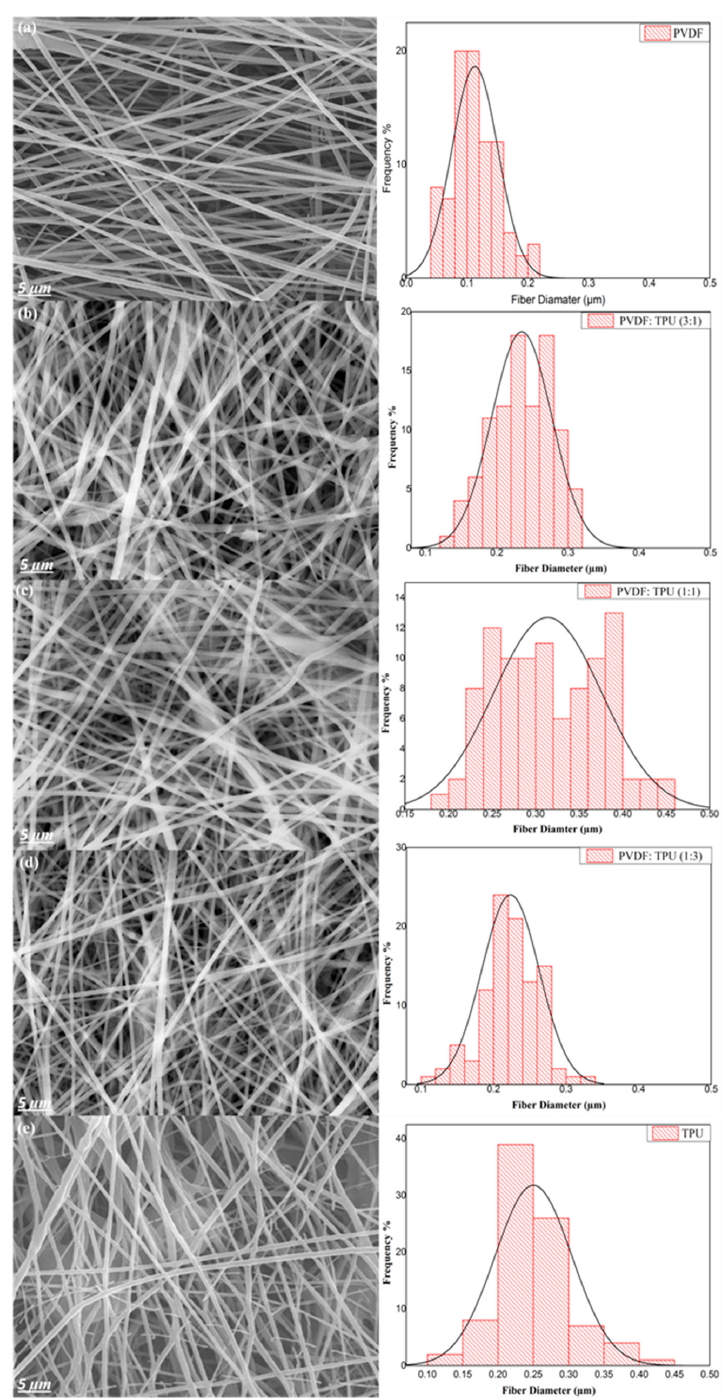
Figure 3. SEM images with fiber diameter distribution for PVDF / TPU composite nanofiber. ( a ) PVDF ( b ) PVDF / TPU 3:1, ( c ) PVDF / TPU 1:1, ( d ) PVDF / TPU 1:3, and ( e )